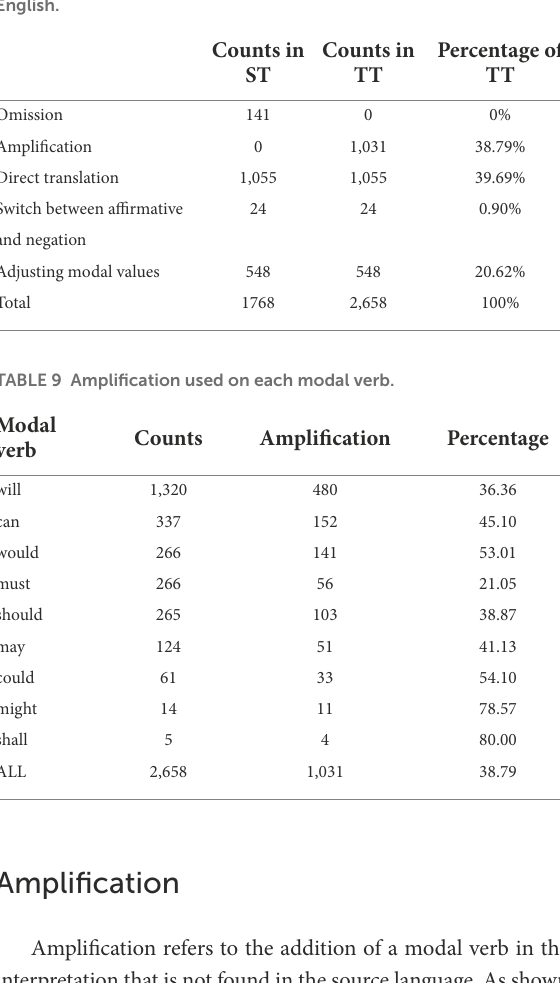
TABLE 7 Average value of modal